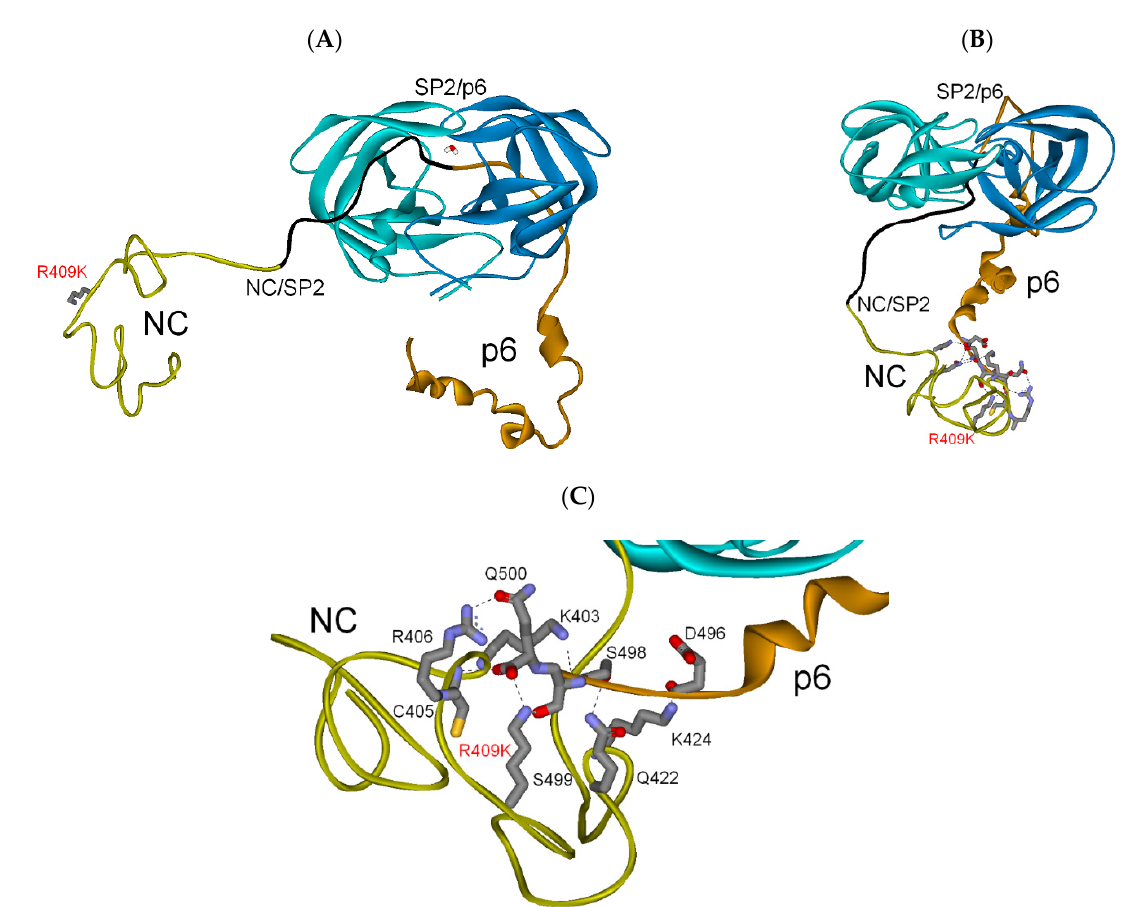
Figure 4. ( A ) HIV-1 PR front view (backbone ribbon, A-subunit teal, B-subunit blue) bound to NC-SP2-p6 polyprotein (backbone ribbon, NC yellow, SP2 black, p6 bronze) at the SP2/p6 cleavage site, tetrahedrally coordinated active site water shown. Gag non-cleavage site PI resistance residue R409K indicated with red label; ( B ) looking down at top of HIV-1 PR bound to the SP2/NC site in the NC-SP2-p6 polyprotein with a substrate-clamp formed between the NC and p6 subdomains mediated by the Gag non-cleavage site PI resistance mutation R409K with red label (bottom), H-bonds as black dashed lines; ( C ) looking upward from underneath of ( B ), close-up of the NC and p6 subdomain substrate-clamp interactions between native NC residues (counter clockwise) K403, R406, C405, Q422, K424, and native p6 residues (right to left) D496, S498, S499, and Q500 (C-terminal Gag residue), NC R409K non-cleavage site PI resistant mutation indicated with red label (center-left). H-bond interactions shown as dashed black lines, NC and p6 labeled as in ( B ), see Results and Discussion Section 3.2.2. for detailed description of the substrate-clamp H-bond